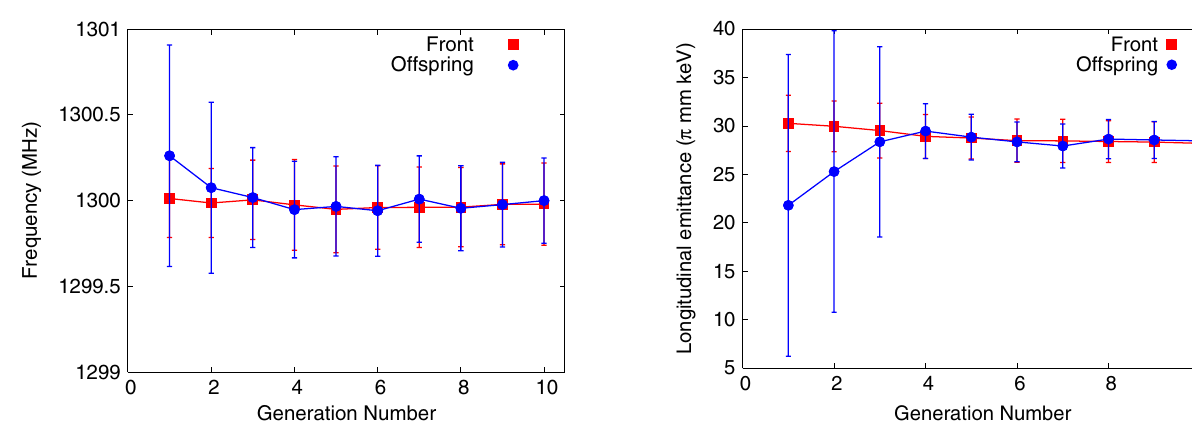
FIG. 27. Average longitudinal emittance for the Pareto-optimal front and offspring for each generation.